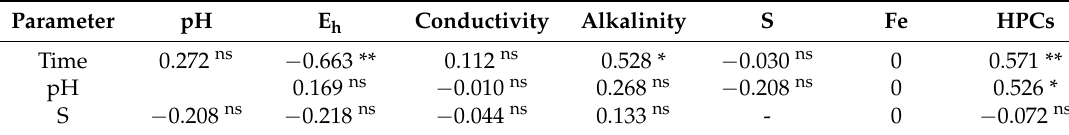
Table 3. Pearson correlation coefficients ( r ) and associated statistical significance level for key parameter correlations in the BS + CSW KLC leachate and microbiological results.